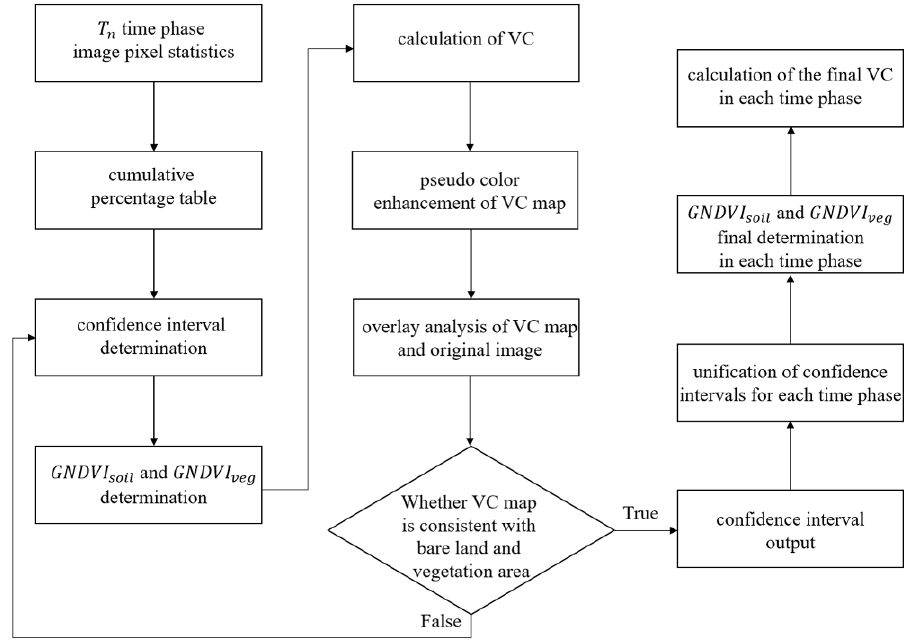
Figure 2. The VC calculation flow chart.